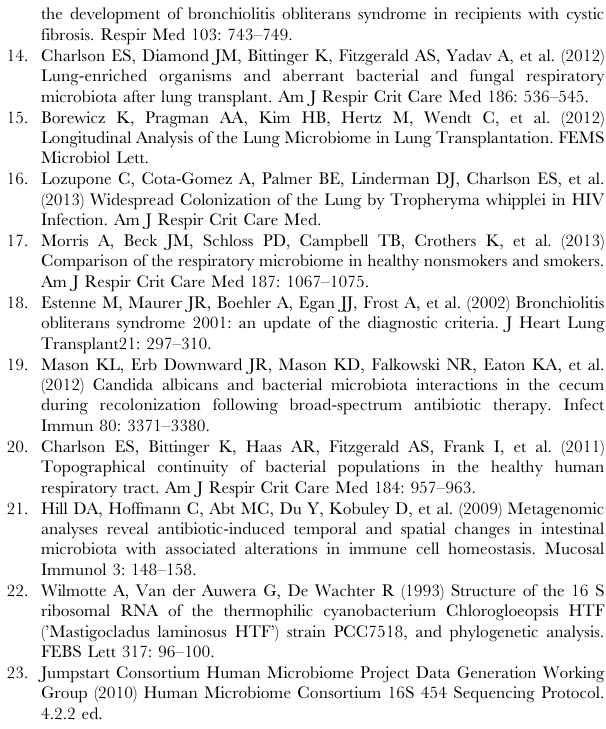
Figure S3 Phylogenetic Tree of Pseudomonas -classified OTUs and Clinically-Obtained and Reference Genomes. MLST phylogeny tree created using DNASTAR SeqBuilder (Lasergene). Numbers in black are branch length. Numbers in blue are bootstrap confidence values. Table S1 NCBI BLAST Results for Prominent Pseudo- monas OTUs. Results restricted to sequences with 100% coverage and identity and ranked in descending order of total